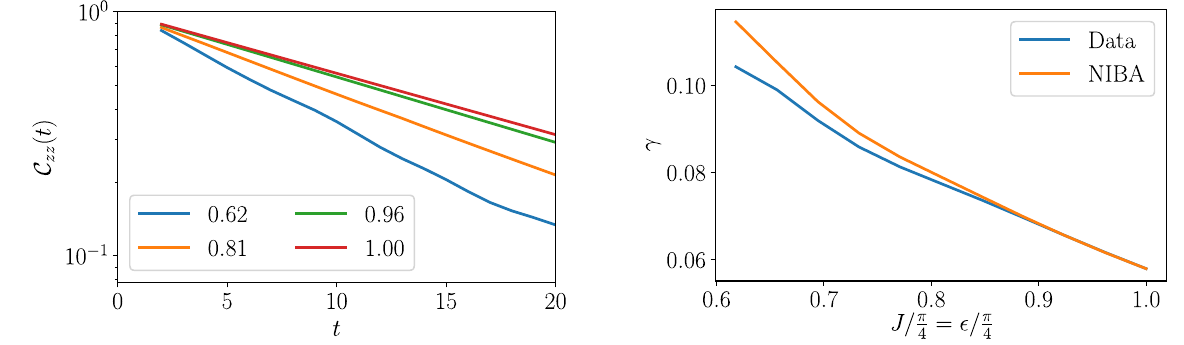
FIG. 11. Left: dynamics of the polarization autocorrelation C zz ð t Þ defined in Eq. (32) of a slow spin, for h ¼ 0 . 29 , ˜ ϵ ¼ 0 . 17 , and a range of values of ϵ ¼ J , in units of π = 4 (reported in the legend). Right: comparison between the numerical (blue line) and the theoretically predicted (orange line) decay rates versus detuning from the PD point. The former is extracted by fitting the decay curves such as those in the left-hand panel, while the latter is described by Eq.